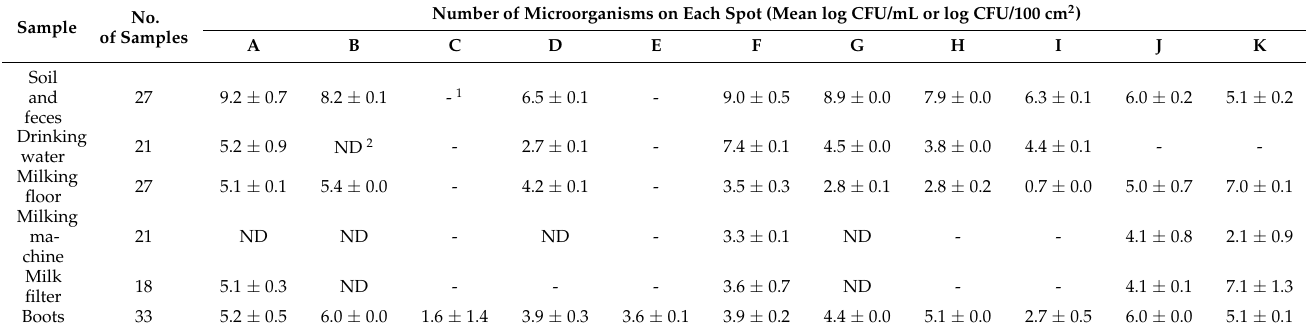
Table 4. Mean ( ± SD) psychrotrophic bacteria counts in the environment of each dairy farm (A to K). Sample